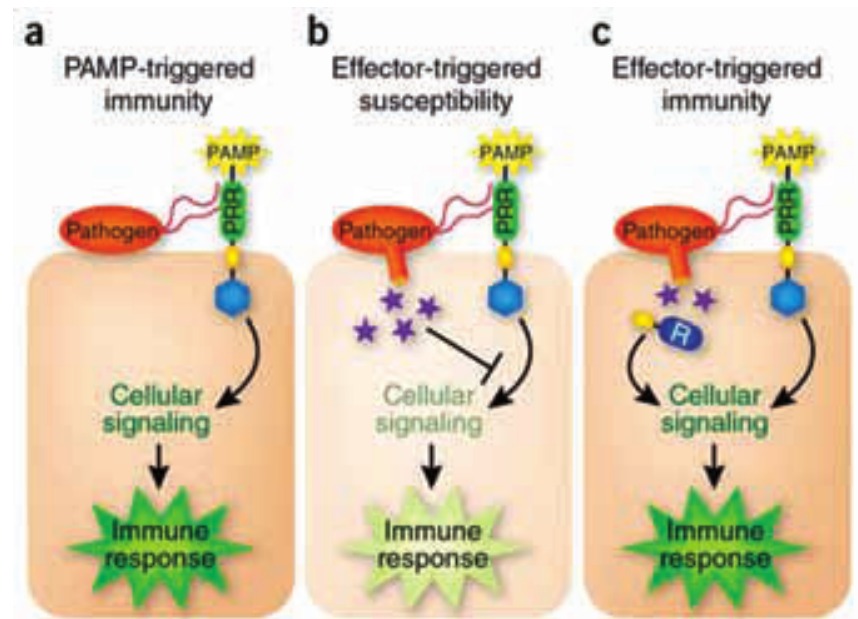
Figure 1. Simplified schematic representation of the plant immune system (a) Upon pathogen attack, pathogen-associated molecular patterns (PAMPs) activate pattern-recognition receptors (PRRs) in the host, resulting in a downstream signaling cascade that leads to PAMP-triggered immunity (PTI)19. (b) Virulent pathogens have acquired effectors (purple stars) that suppress PTI, resulting in effector-triggered susceptibility (ETS). (c) In turn, plants have acquired resistance (R) proteins that recognize these attacker-specific effectors, resulting in a secondary immune response called effector-triggered immunity (ETI) (Corné et al